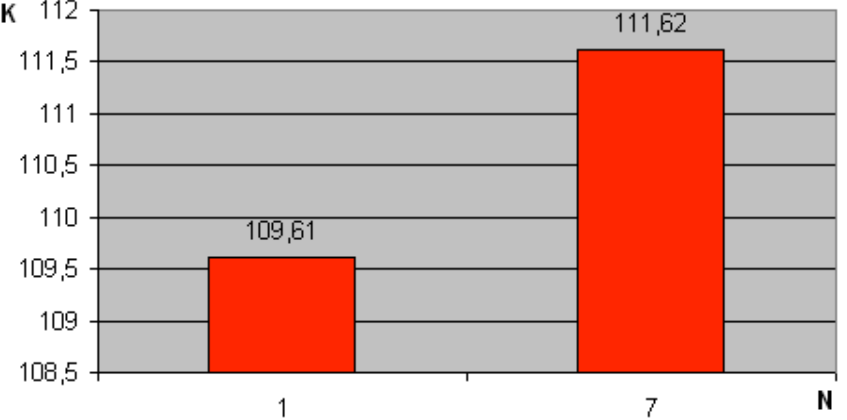
), N – number of the Cooper test. 1